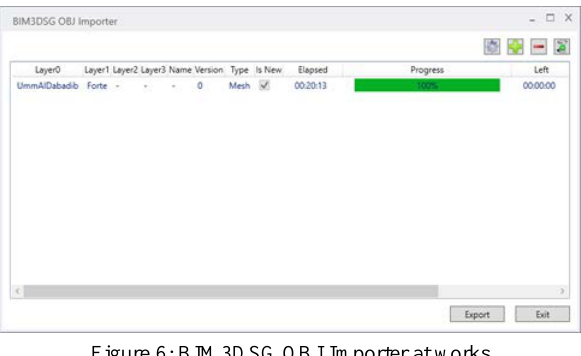
Figure 6: BIM3DSG OBJ Importer at works